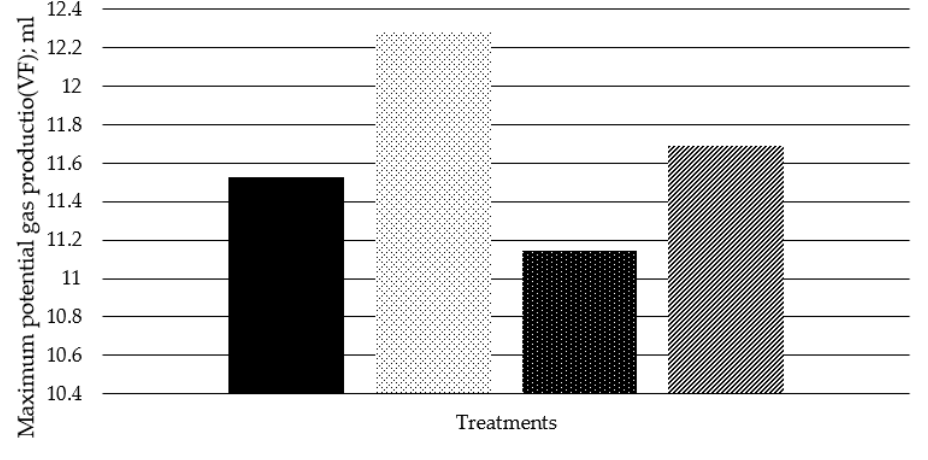
Figure 2. Maximum potential of in vitro gas production ( VF ) from corn silage performed with inoculum of steers receiving different nutritional additives estimated by the Dual- pool Logistic model.